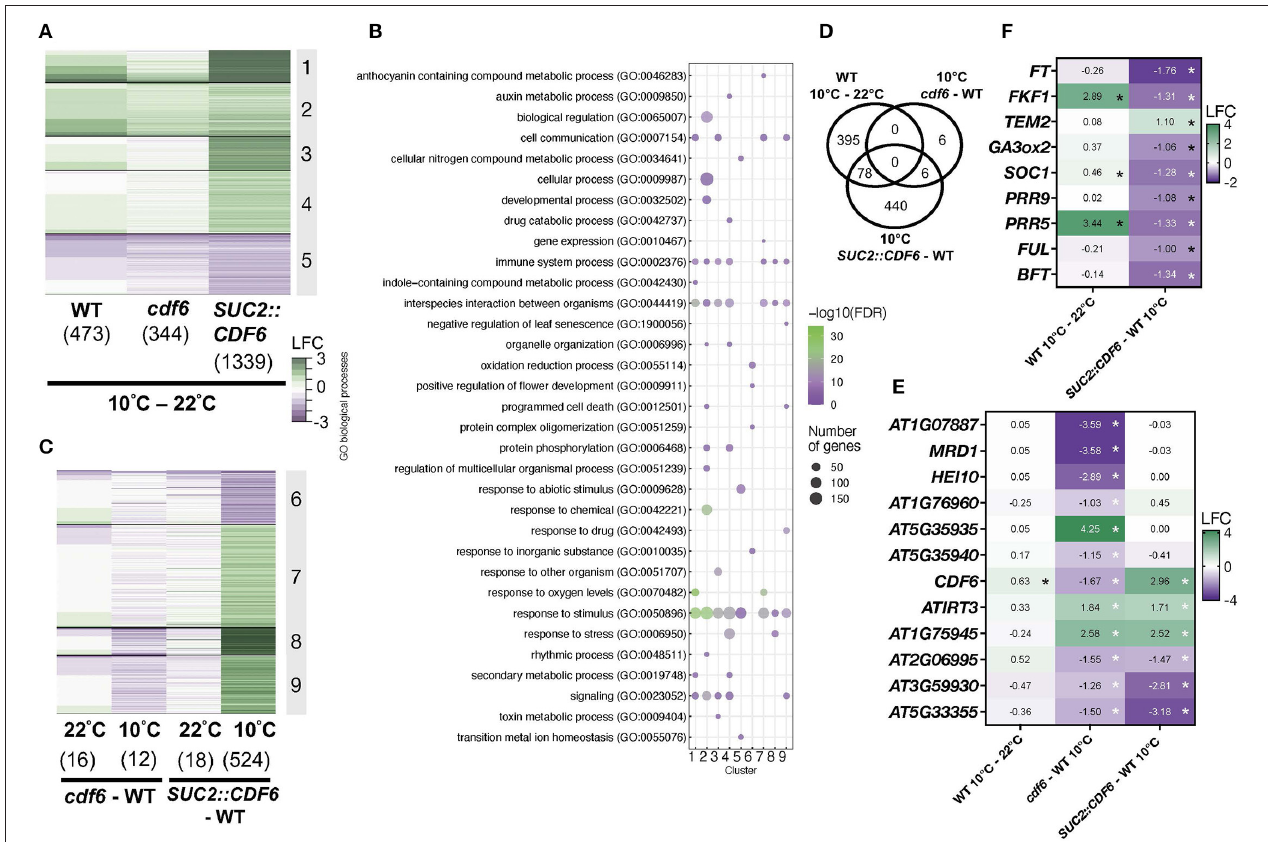
FIGURE 3 | Vasculature-expressed CDF6 regulates cold-responsive and flowering-associated genes in the morning. (A) Temperature and (C) genotype-specific DEGs [defined as − 1 > Log 2 fold change (LFC) > 1 and false discovery rate (FDR) < 0.05] identified after RNA-sequencing of three replicates of 11-day-old WT, SUC2::CDF6, and cdf6 seedlings. Seedlings were grown in constant light for 2 days at 22 ◦ C after entrainment for 8 days in diurnal (LD) conditions before sampling at ZT0 after 1h at 10 ◦ C or continuously at 22 ◦ C. (B) Summary of enriched GO biological process terms with indicated false discovery rate (FDR-corrected p -value < 0.05). GO terms selected based on a previously published protocol using a FDR cut-off < 0.05 ( Bonnot et al., 2019). (D) DEGs specific to the cold response vs. CDF6 mis-regulation during cold stress. Expression profiles of (E) 12 DEGs mis-expressed in cdf6 and (F) flowering-associated genes identified in SUC2::CDF6 during cold stress; *FDR <